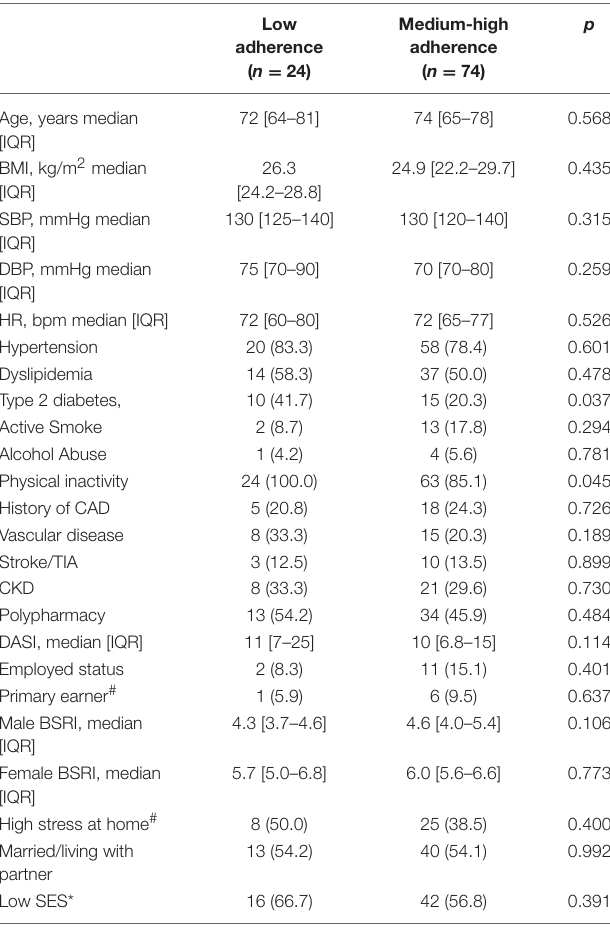
TABLE 3 | Clinical and gender-related factors in men according to pre-admission medication adherence.